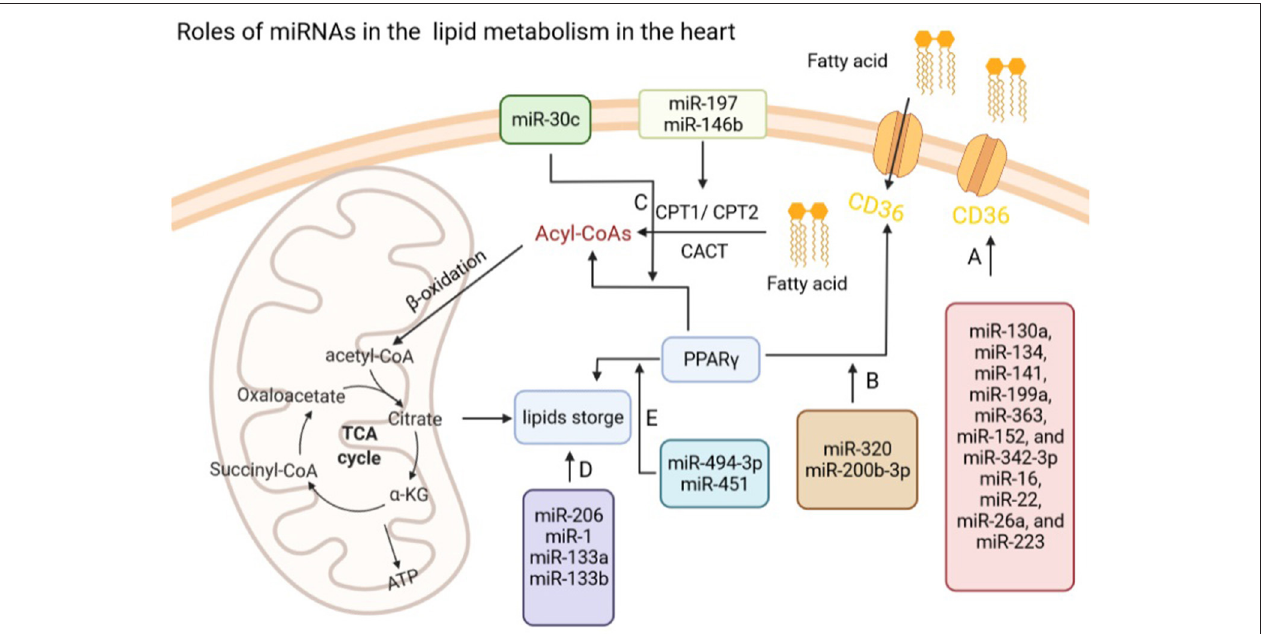
FIGURE 2 | Roles of miRNAs in lipid metabolism in the heart. (A) miRNAs regulate fatty acids transport via modulating the expression of CD36 in the heart. (B) miR-320 and miR-200b-3p regulate fatty acid transport via PPAR γ . (C) miR-197 and miR-146b modulate Acyl-CoAs by CPT1/2, while miR-30c regulates the production of Acyl-CoAs through targeting PPAR γ . (D) miR-206, miR-1, and miR-133a/b influence lipids storage in the heart. (E) miR-494-3p and miR-451 regulate lipids storage via modulating the expression of PPAR γ in the heart. CD36, fatty acid translocase (FAT)/CD36; CPT1/2, carnitine palmitoyltransferase 1/2; PPAR γ , peroxisome proliferator-activated receptors (PPAR γ